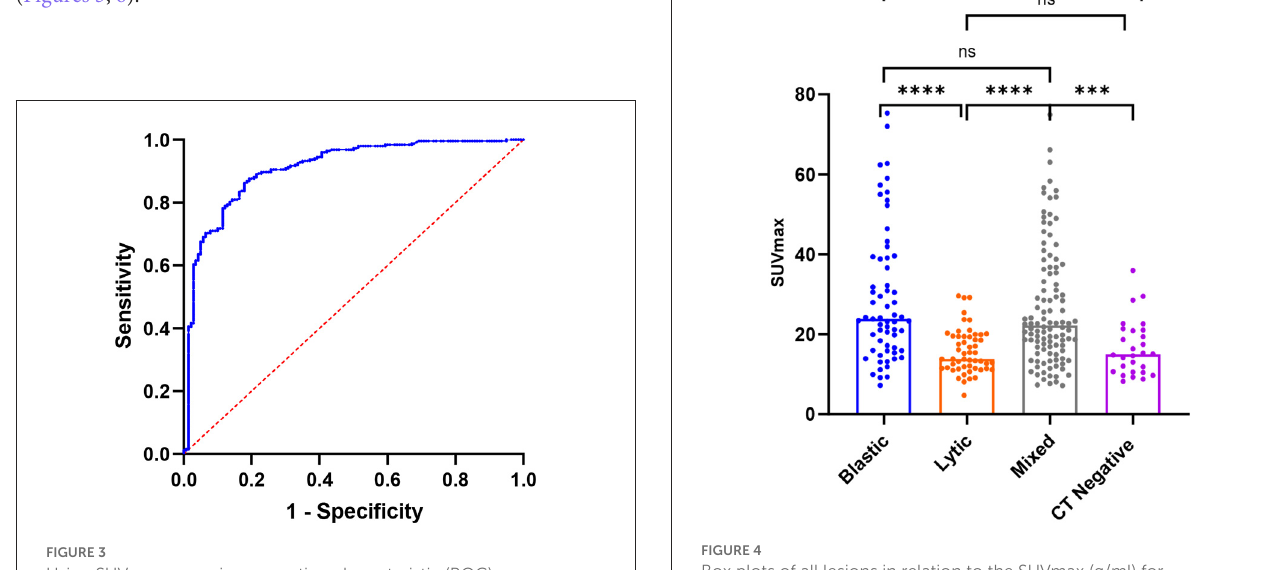
FIGURE3 Using SUVmax, a receiver operating characteristic (ROC) curve was created to differentiate benign bone lesions from bone metastases; the area under the curve is 0.9097 (95% CI 0.8786–0.9407).